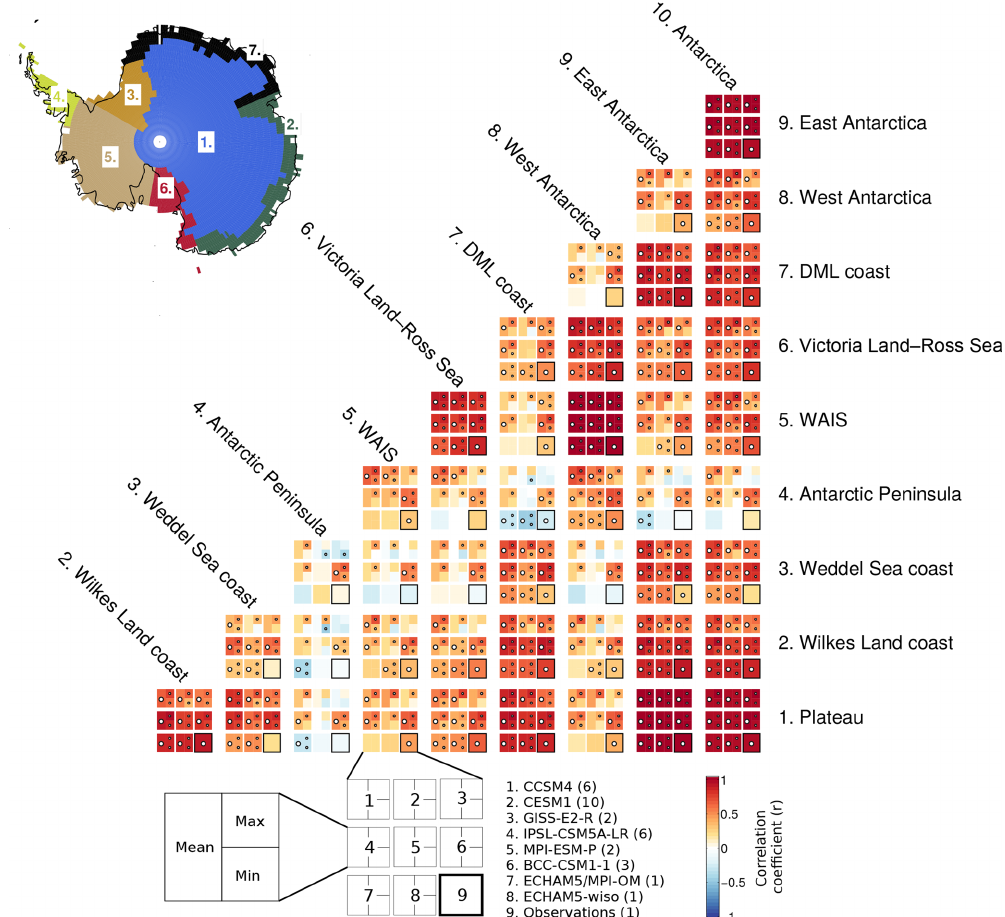
Figure 3. Simulated and observed Pearson correlation coefficients between mean annual surface temperature over the 1958–2005CE period in 10 different subregions covering Antarctica (East Antarctic plateau – referred to as “Plateau”, Wilkes Land coast, Weddell Sea coast, Antarctic Peninsula, WAIS, Victoria Land–Ross Sea, DML coast, West Antarctica, East Antarctica and Antarctica as a whole). The order displayed for the models and the observation values is shown below the main panel. The number of ensemble members for each model is indicated in parentheses. For each model, the mean of the correlations over all the members is shown, along with the value of the ensemble member that has the highest (max) and the lowest (min) correlation. The presence of a white circle represents combinations for which the null hypothesis of no correlation can be rejected at the 0.05 level. In the case of the mean value, there is the white circle if the majority of the ensemble members are statistically significant. The observation is the reconstruction based on the instrumental observations of Nicolas and Bromwich